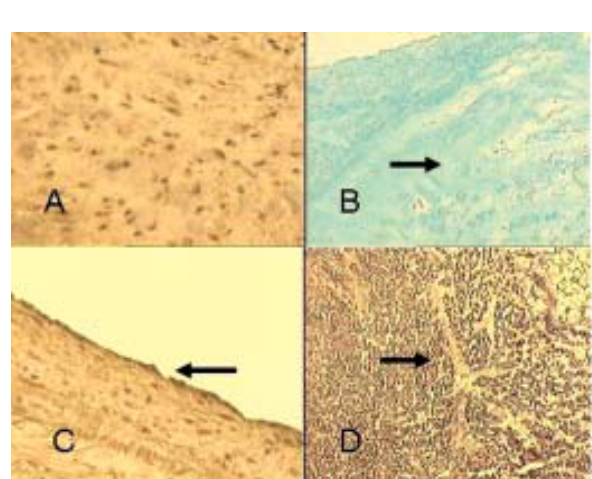
Fig. 4 - Análise histológica por microscopia ótica dos enxertos descelularizados. Fotomicrografias de corte histológico de conduto pulmonar, homoenxerto criopreservado, aumento 40x.